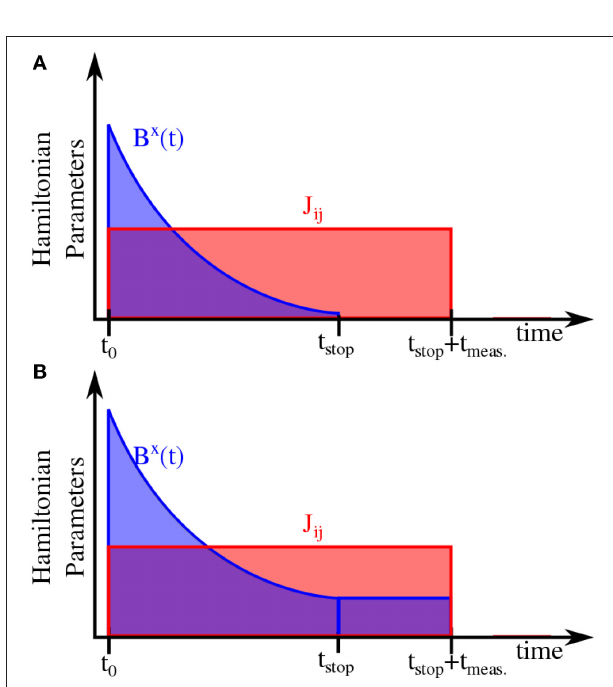
FIGURE 7 | Schematic diagram of the experimental protocol used for the transverse field Ising model. (A) The transverse magnetic field as a function of time is diabatically ramped down to a chosen value, B x ( t stop = 6 τ ) . Then B x ( t ) is immediately quenched to 0 before the start of the measurement time interval, t meas . . (B) The transverse magnetic field is ramped down and held constant at a final value determined by t = t stop .